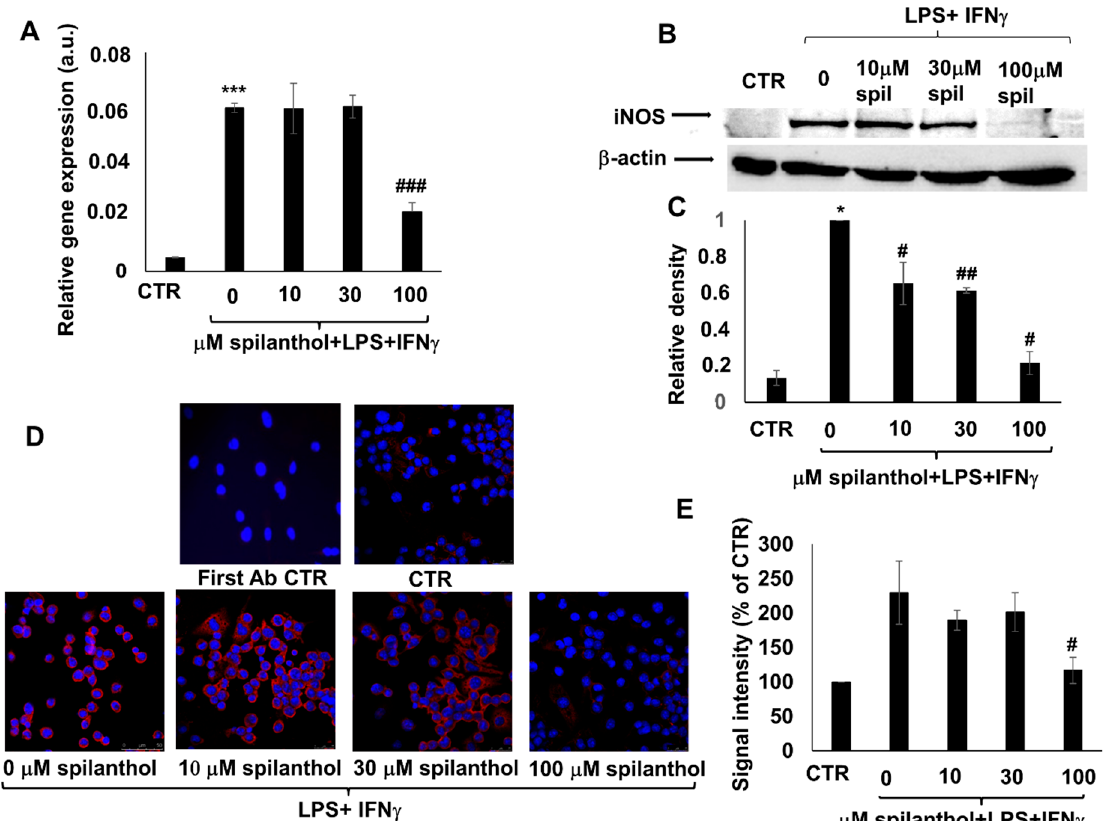
Figure 5. Spilanthol suppresses NO production in LPS/IFN γ -treated RAW264.7 macrophages by mitigating expression of iNOS mRNA and protein. ( A ) Increasing concentrations of spilanthol (0–100 µM) reduced iNOS mRNA expression in RAW264.7 macrophages activated with 10 nM LPS + 10 ng / mL IFN γ . ( B ) iNOS protein expression was also concentration-dependently inhibited by spilanthol. ( C ) Relative densities of the iNOS bands were determined. ( D ) Microscope images showing immunofluorescent staining of the spilanthol treated cells for iNOS (red) confirmed the gradual loss of iNOS staining with increasing concentrations of the drug. Blue is DAPI nuclear counterstain. ( E ) Intensities of the immunofluorescent iNOS signals were quantified in ImageJ software.